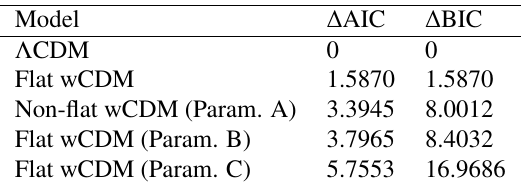
Table 4: ∆ AIC and ∆ BIC values for the five di ff erent models